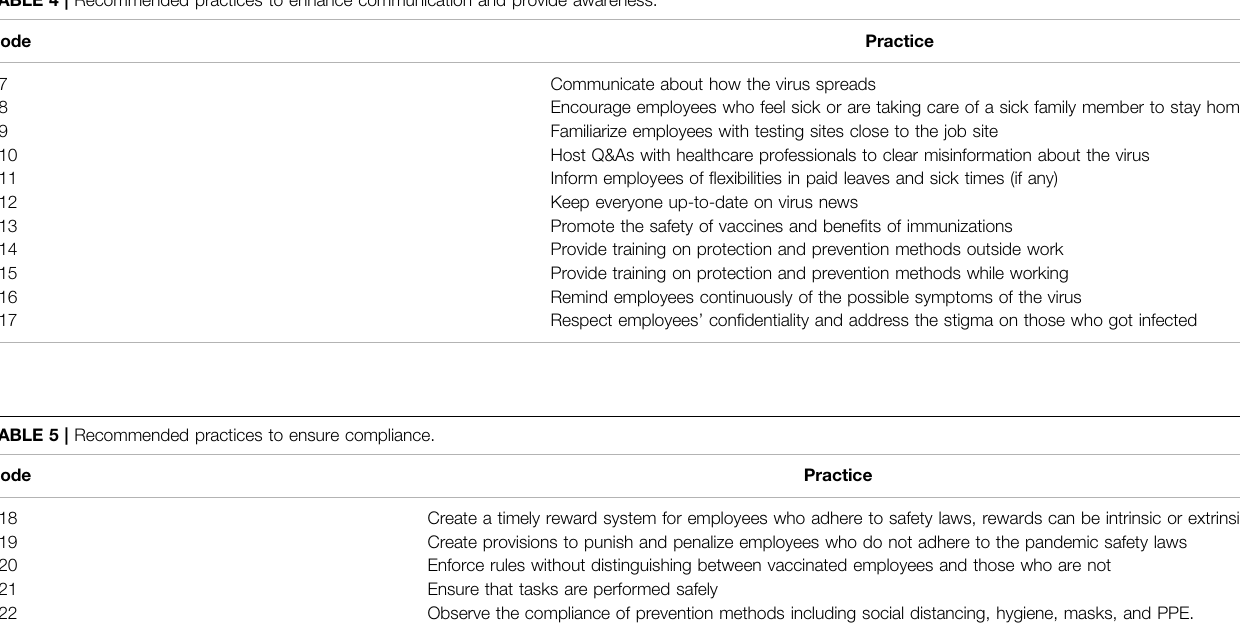
TABLE 4 | Recommended practices to enhance communication and provide awareness.